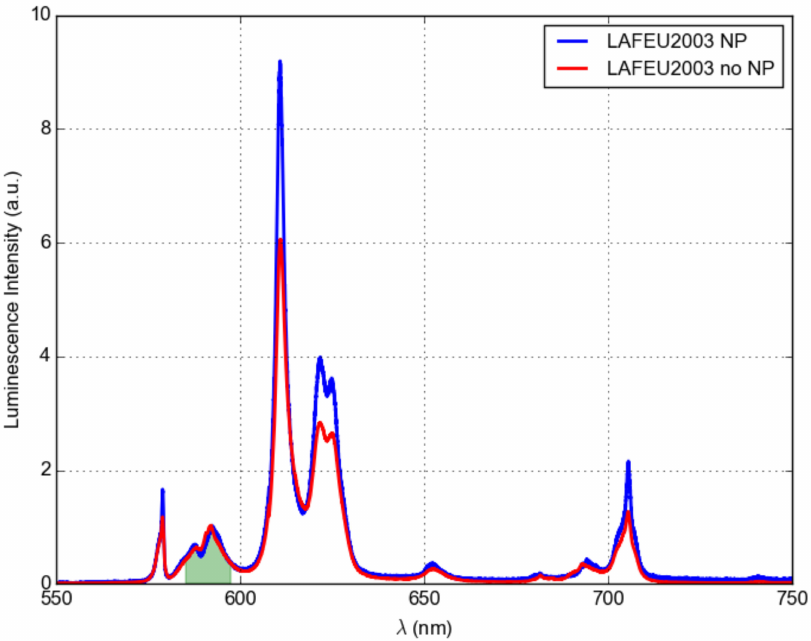
Figure 13. Luminesce spectrum of Eu 3+ -doped (15%) LaF 3 nanocomposite LaF 3 . The intensity is normalized to the peak indicated by the green